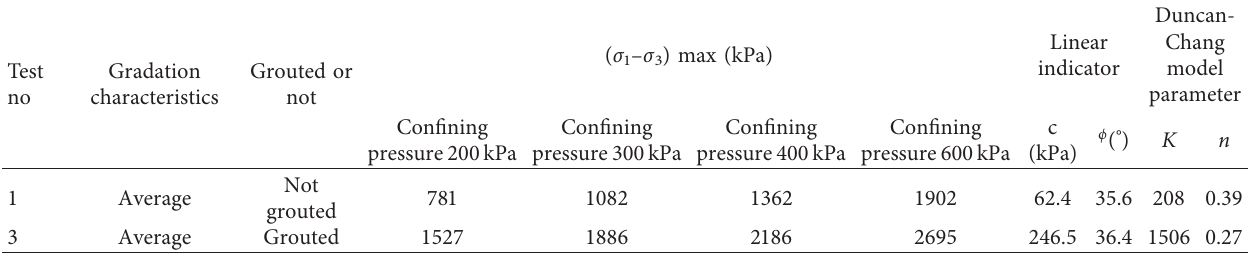
Table 2: Strength parameters and Duncan-Chang model parameters of rockfill materials with average gradation before and after grouting reinforcement.